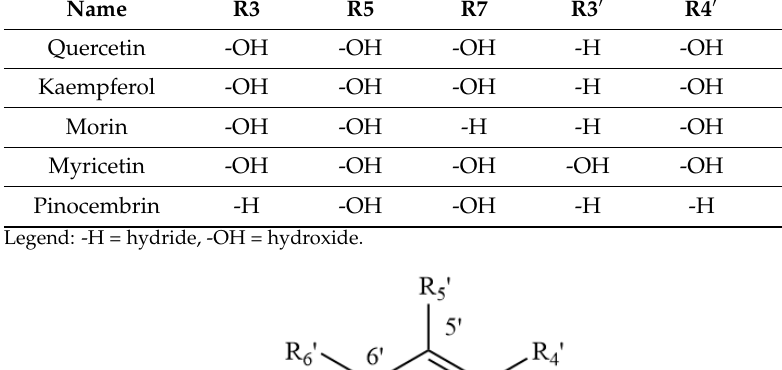
Figure 2. Structure of Irilone ( a ) and Pseudobaptigenin ( b ). Table 2. Flavonoids reported in clover plants and honey (see Figure 3 for general structure).